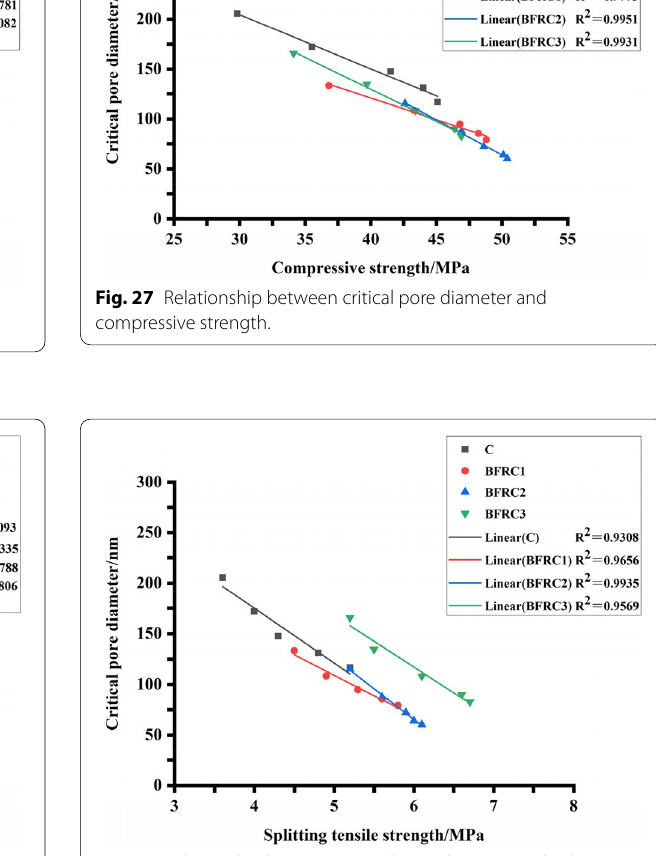
Fig. 26 Relationship between pore size distribution and splitting tensile strength (BFRC3).